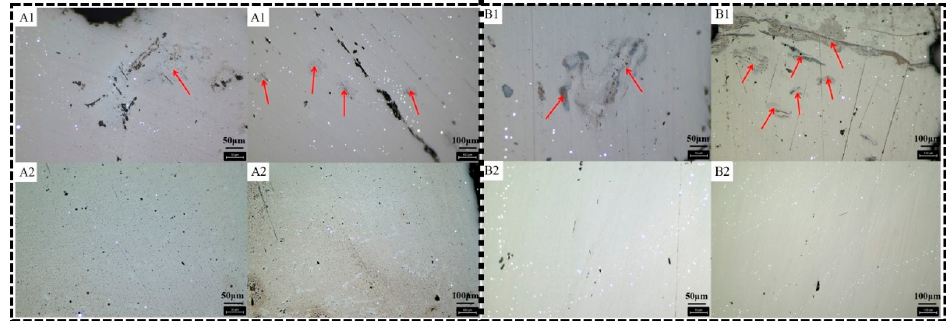
Figure 8. Optical microscope images of the tundish covering fluxes before and after plasma heating: A1, A group: before heating; A2, A group: after heating; B1, B group: before heating; B2, B group: after heating.